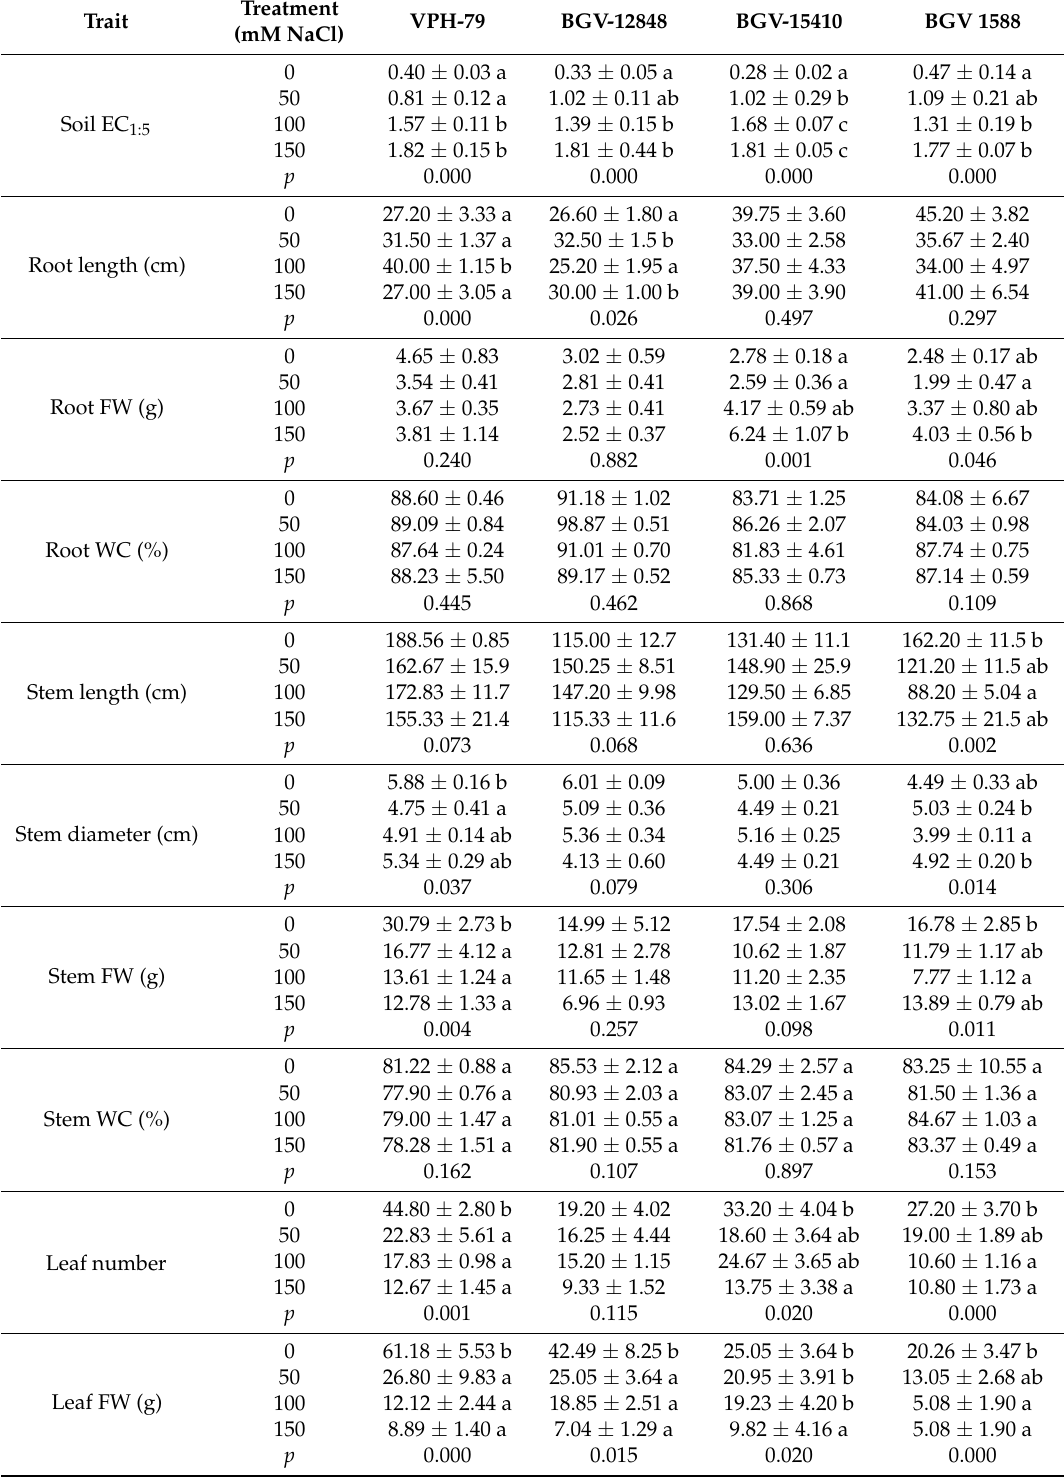
Table 1. Effect of salinity on electric conductivity (EC) in the pots and on plant growth parameters for the four Phaseolus lunatus cultivars. FW, fresh weight; WC, water content. Means followed by SE ( n = 5). Different letters indicate significant differences within each cultivar according to Tukey’s test ( α = 0.05). p values according to one-way